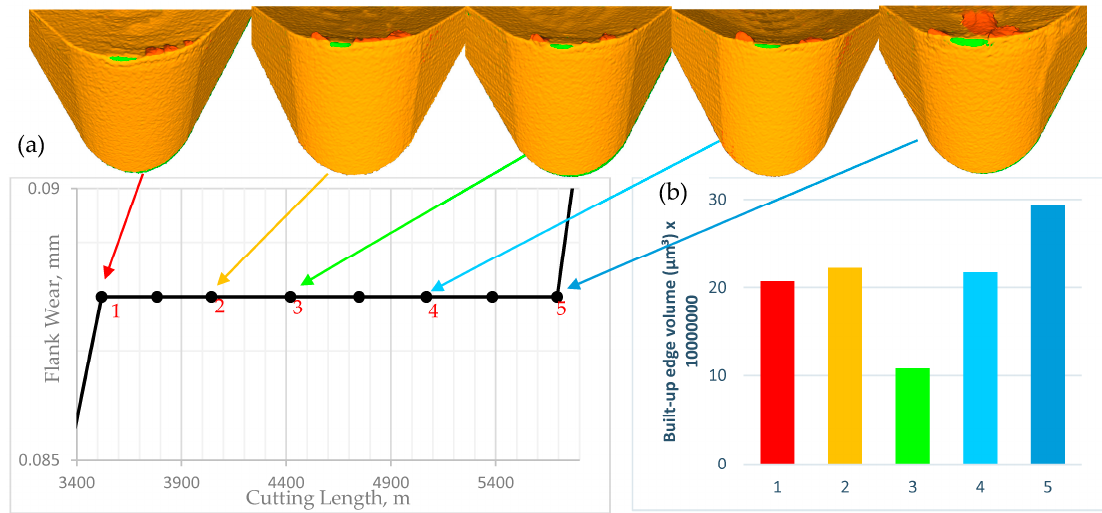
Figure 4. ( a ) Alicona 3D images of the cutting tool during steady state zone showing BUE propagation; and ( b ) BUE volume.